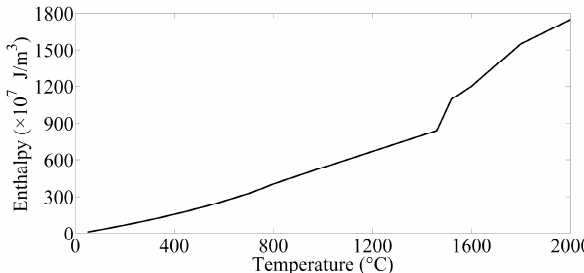
Figure 3. Enthalpy values of steel sheets with different temperatures.